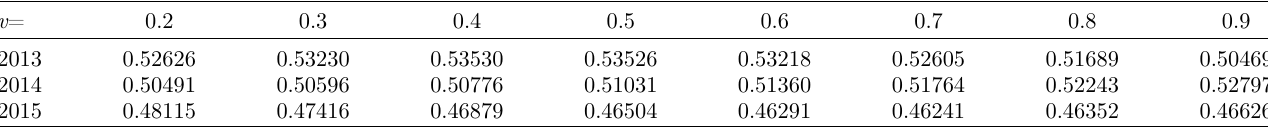
^ Table 6. P ð U > u 0 j V > v Þ according equation (2), years 2013, 2014 and 2015, with u 0 given by Table